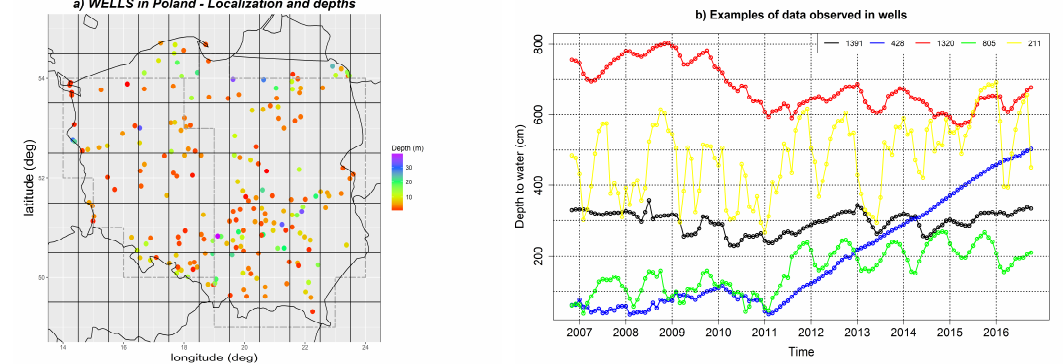
Figure 1. Polish well localization and approximate depths ( a ) and example depths variations ( b ).